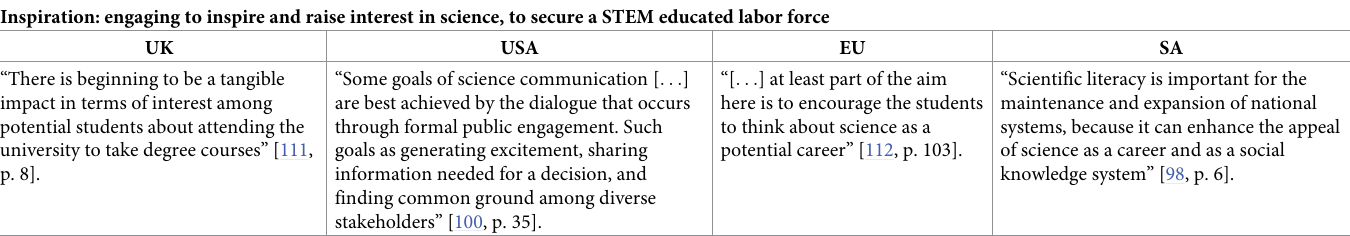
Table 8. Inspiration as motivation for engagement in policy